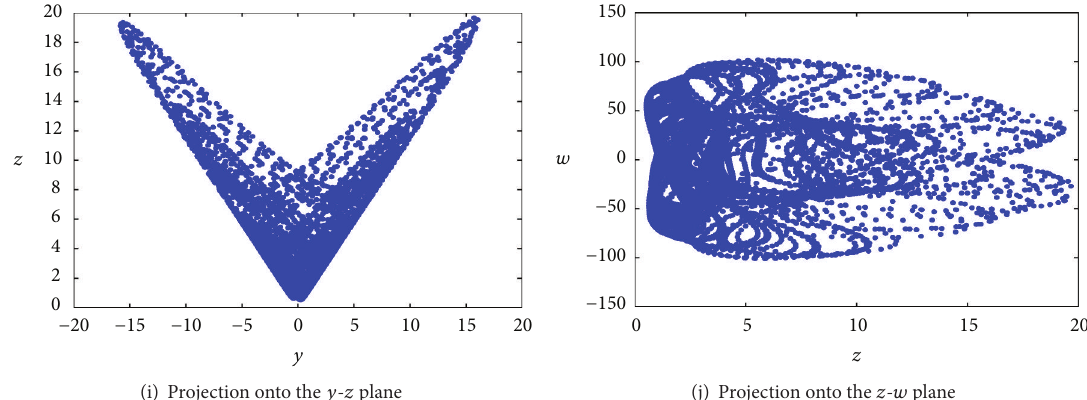
Figure 1: Phase portraits of the dynamic system when 𝑥 = 11.28 , 𝑦 = −11.21 , 𝑧 = −9 , and 𝑤 = 20.49 and 𝑎 = 0.9 , 𝑏 = 12 , 𝑐 = 6 , 𝑑 = 0.06 , and 𝑒 = 20